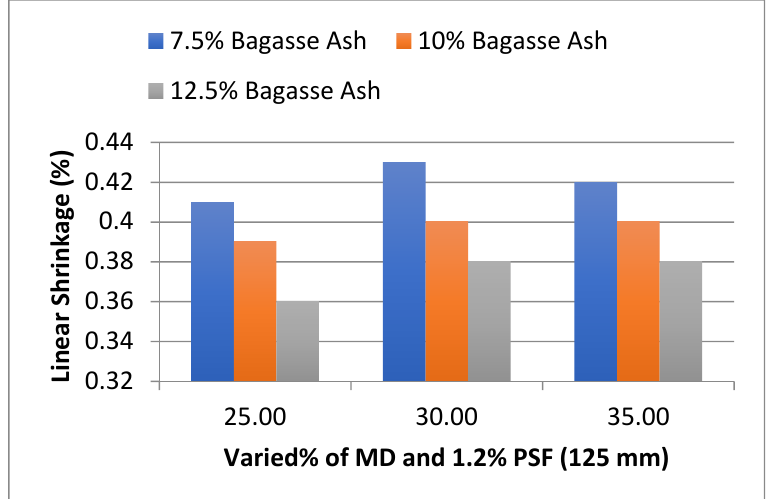
Figure 18. E ffect of MD and BA on linear shrinkage of block reinforced with 1% PS fiber (125 mm). However, it was observed from the experimental results that linear shrinkage showed a decrement with an increase in bagasse ash at constant marble dust content. It was found that linear shrinkage showed a similar trend with 1.2% PSF content too.